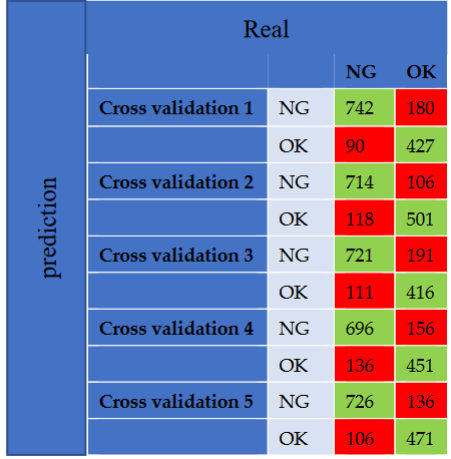
Figure 10. Vanilla convolutional neural network (CNN) confusion matrix of five cross validations.